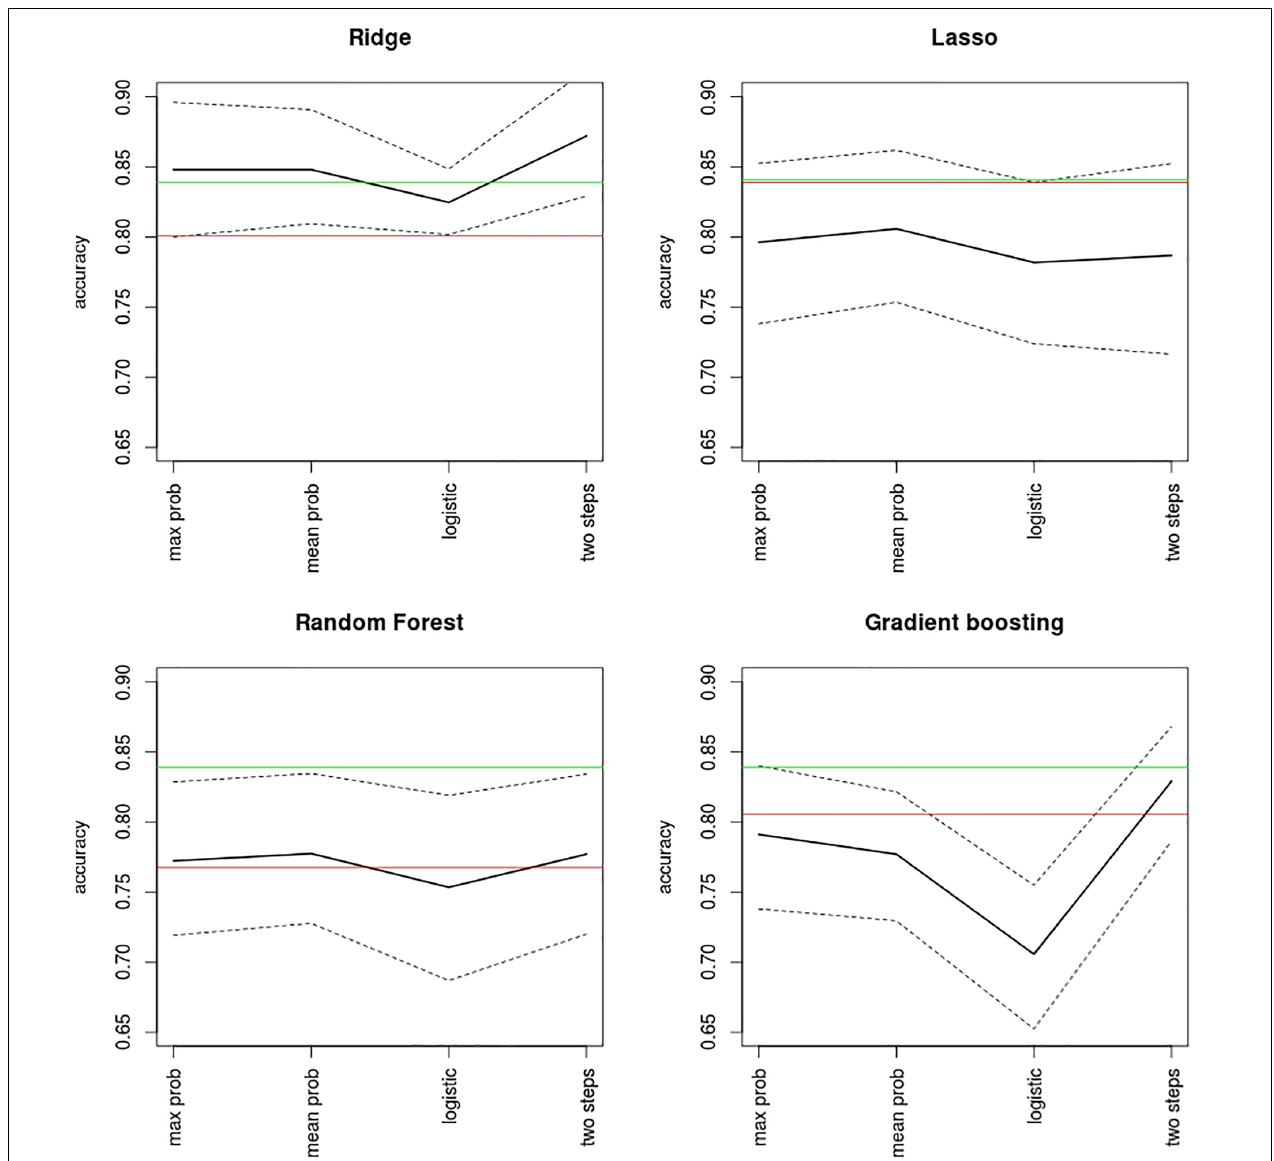
FIGURE 4 | Accuracy levels reported by probability-based and two-step multimodal integration approaches. Mean accuracy (black line) and its bootstrap 95% confidence levels (dashed lines) are shown for each classifier. Mean accuracies achieved by the best unimodal classification (red line) and by the 1D-CNN algorithm (green line) are also shown for the purposes of comparison. Max prob, maximum output probability algorithm; mean prob, mean output probability algorithm; logistic, logistic model on the